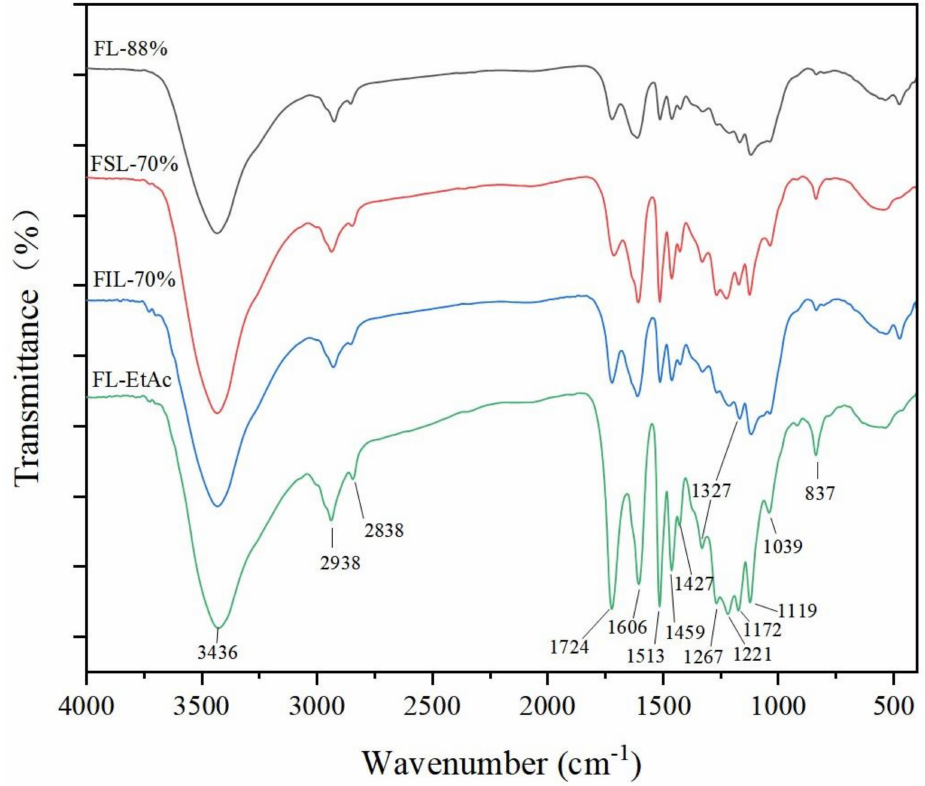
Figure 2. FTIR spectra of unacetylated lignin samples obtained from two-step formosolv